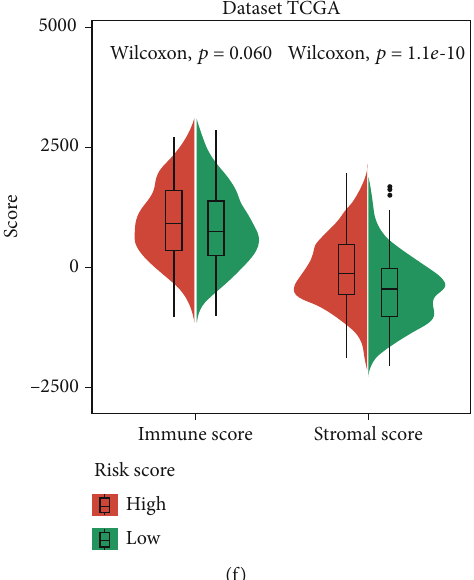
Figure 8: E ff ect of immune in fi ltration on the prognosis of HNSCC patients: (a, c) impact of the stromal score and immune score on overall survival in the GSE65858 cohort based on Kaplan-Meier analysis; (b, d) impact of the stromal score and immune score on overall survival in the TCGA HNSCC cohort based on Kaplan-Meier analysis; (e) association between immune score, stromal score, and risk score in the GSE65858 cohort; (f) association between immune score, stromal score, and risk score in the TCGA HNSCC